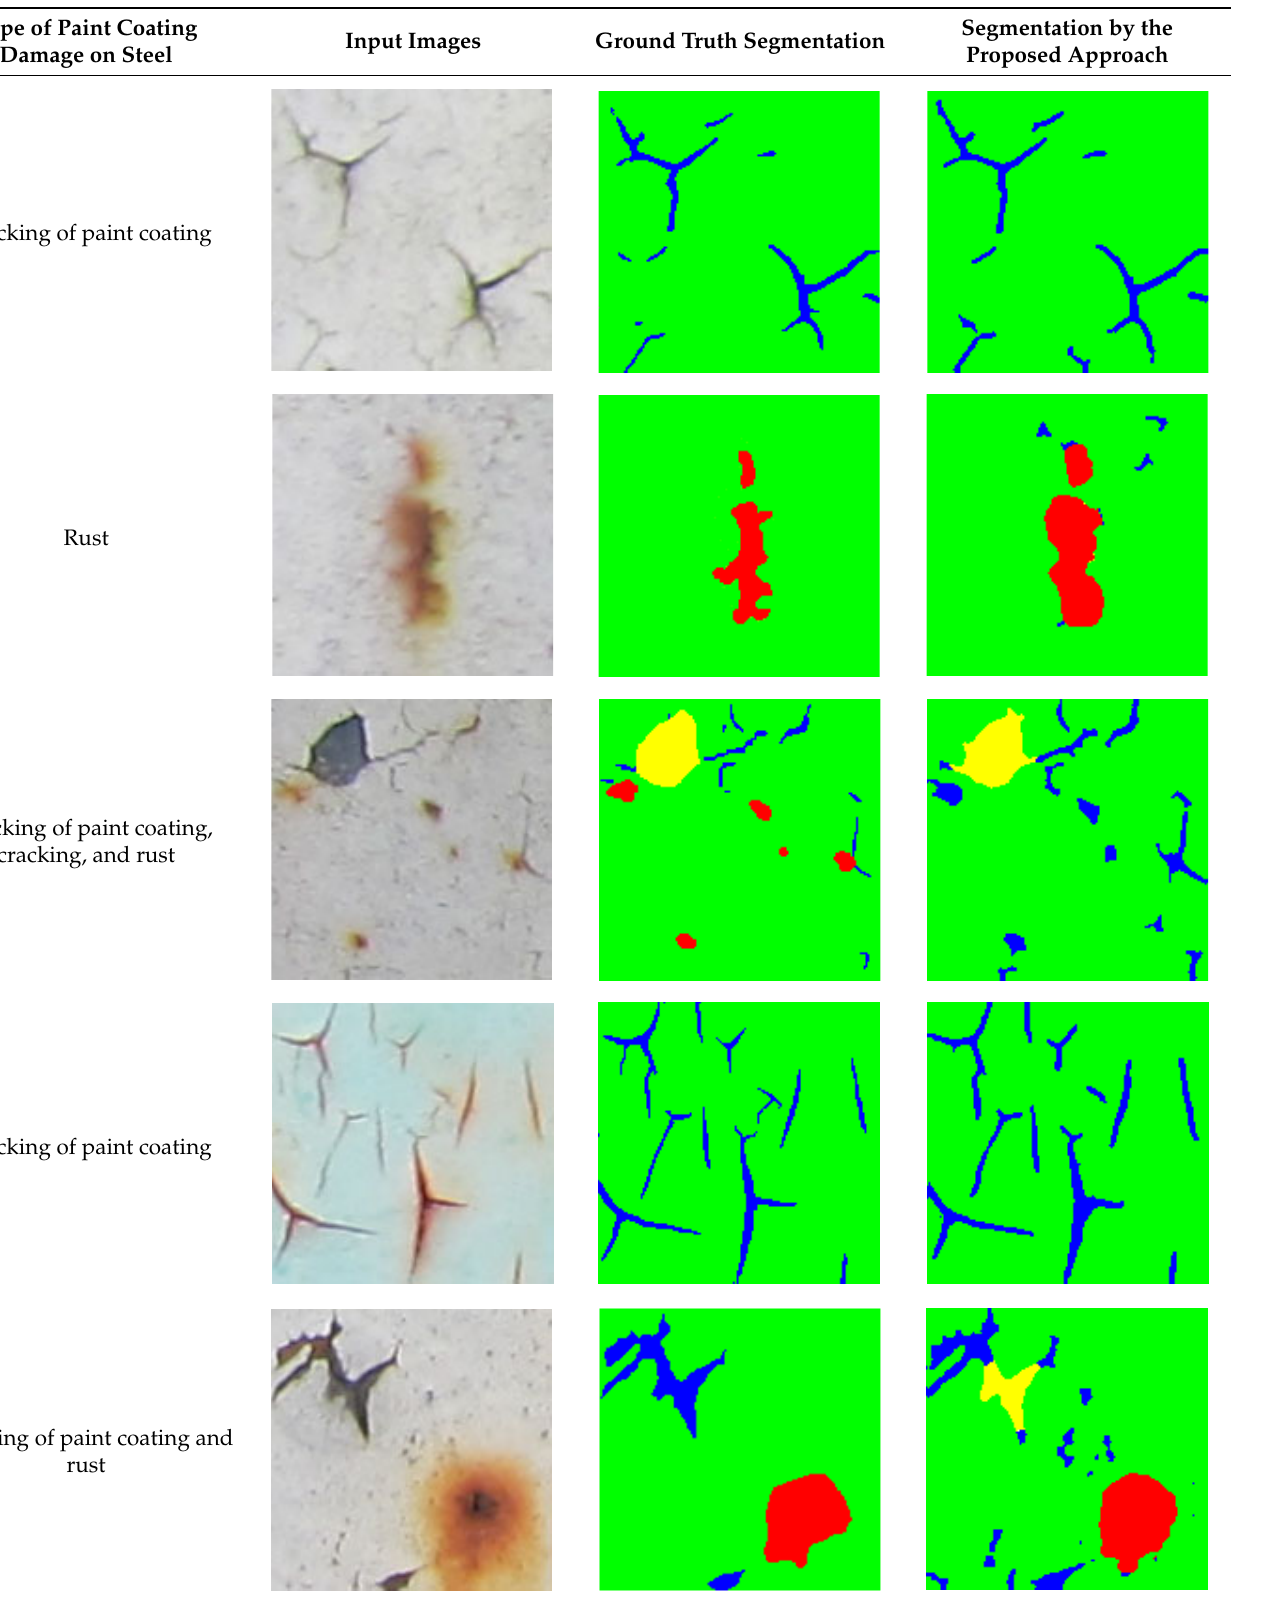
Table 2. Examples of ground truth data of rust segmentation.